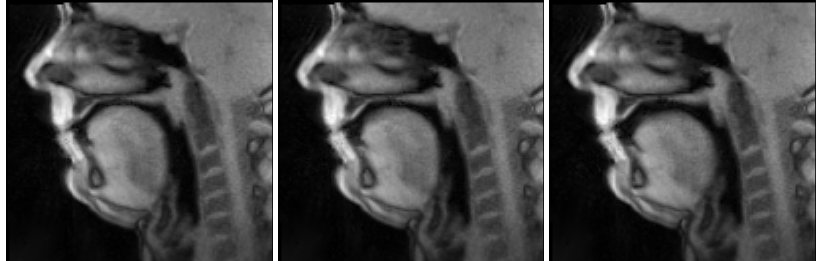
Figure 2. Illustrative examples of midsagittal real-time MRI images of the vocal tract, for different speakers and sounds.